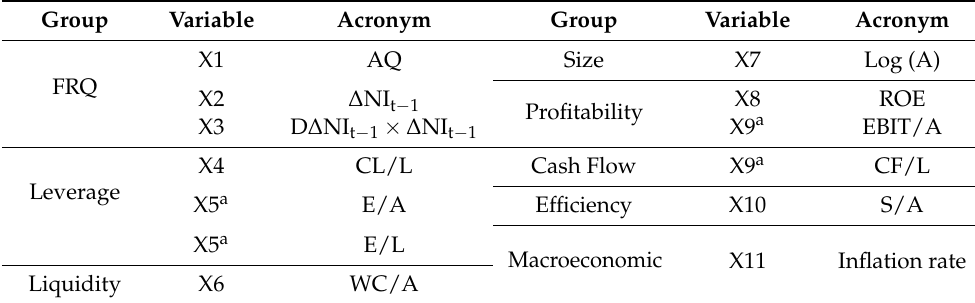
Table 1. Ratios selected by the stepwise method and Pearson correlation.